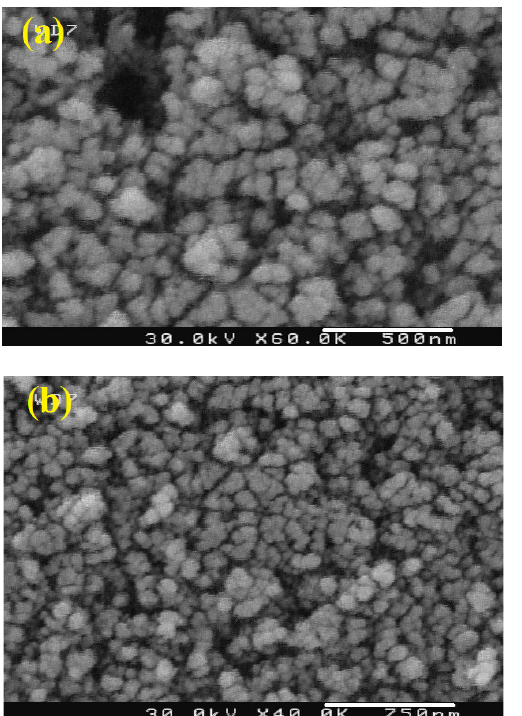
Fig. 4. SEM images of magnetite nanoparticles prepared at 100W Fig. 5. SEM images of magnetite synthesized at 150W Fig. 5. SEM images of magnetite synthesized at 150W